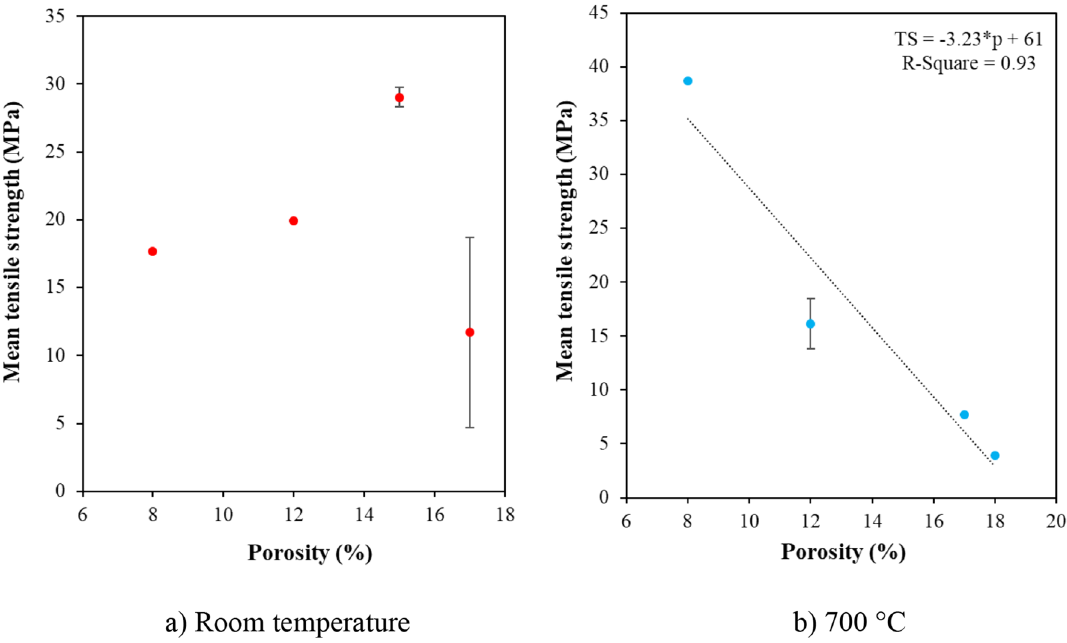
Fig. 10 Correlation between tensile strength and porosity for specimens tested using the ETMT rig at: a Room temperature; b 700 °C. Linear curve fitting was performed where possible. Parameters TS and p stand for tensile strength and porosity,